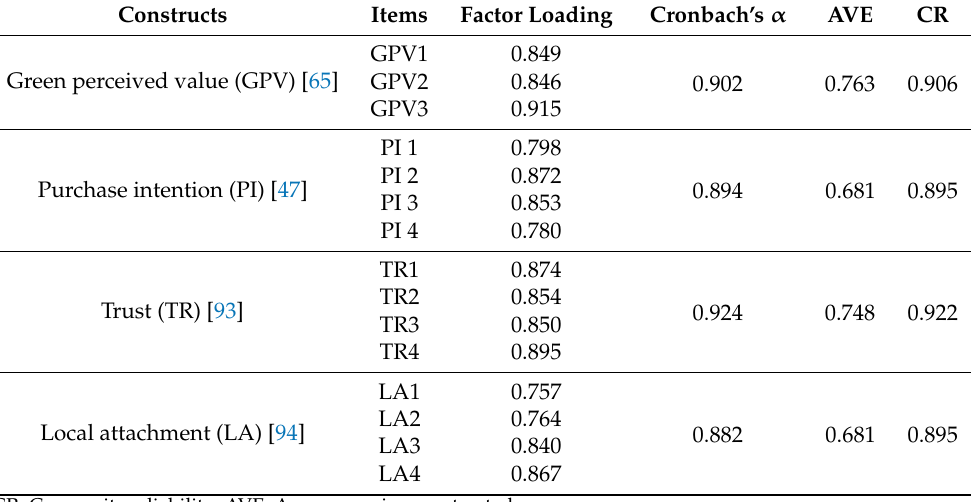
Table 2. Results of factor loading, reliability, and validity.